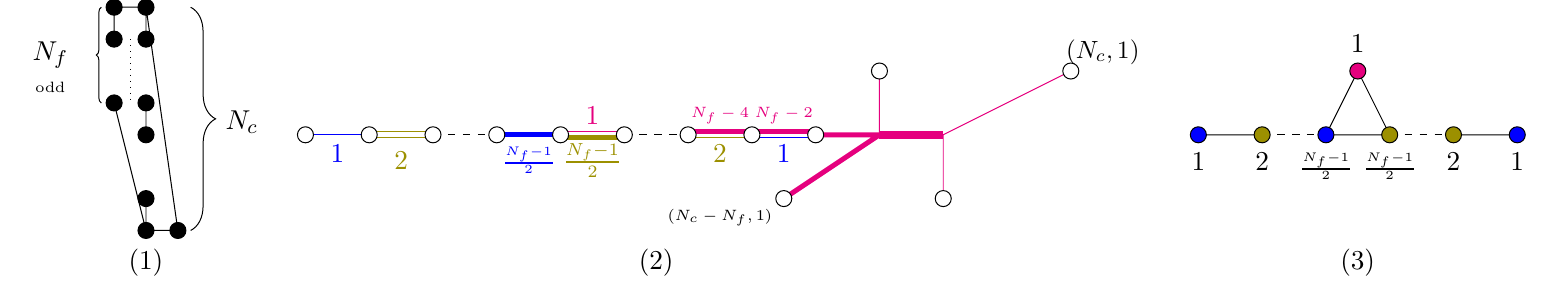
Figure 9 . (1) Toric Diagram representing SQCD with N f N c and N f odd at finite gauge coupling where masses are set to zero. (2) Brane Web ≤ indicating the mesonic branch of the Higgs Branch (3) magnetic Quiver whose 3d Coulomb Branch is the mesonic branch of the Higgs Branch of our SQCD. For N f < N c the Higgs branch consists only of the mesonic branch.